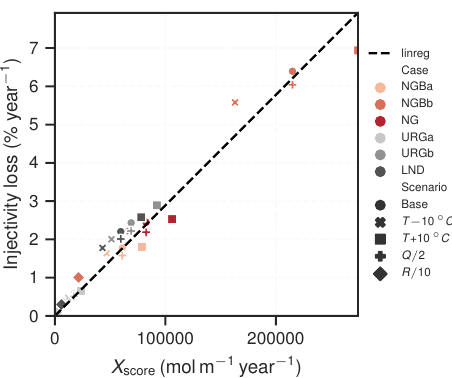
Figure 9. Scaling score plotted against injectivity loss per year as calculated from reactive transport simulations for the considered geothermal cases and different scenarios (Table 4). The dashed line is a linear regression without intercept. Using Equation (15) for X score , the slope is 2.89 · 10 − 5 and R 2 =